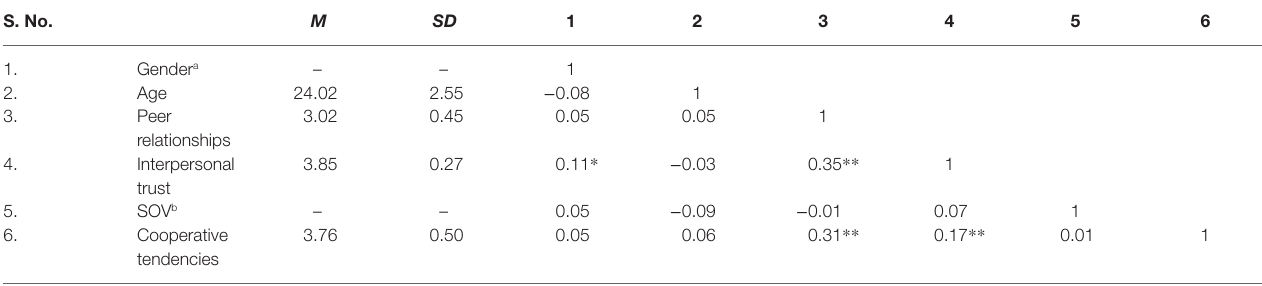
TABLE 1 | Means, standard deviations, and correlation matrices of variables. S. No.